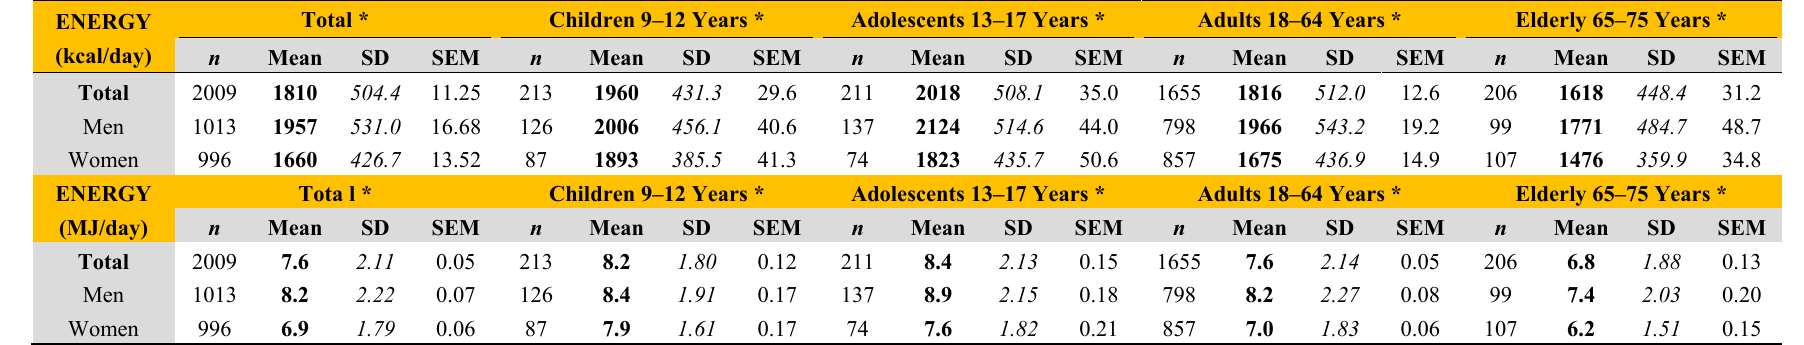
Table 1. Total daily energy intake, by sex and age group, in the ANIBES survey of the Spanish population aged 9–75 years, expressed as kilocalories and megajoules.